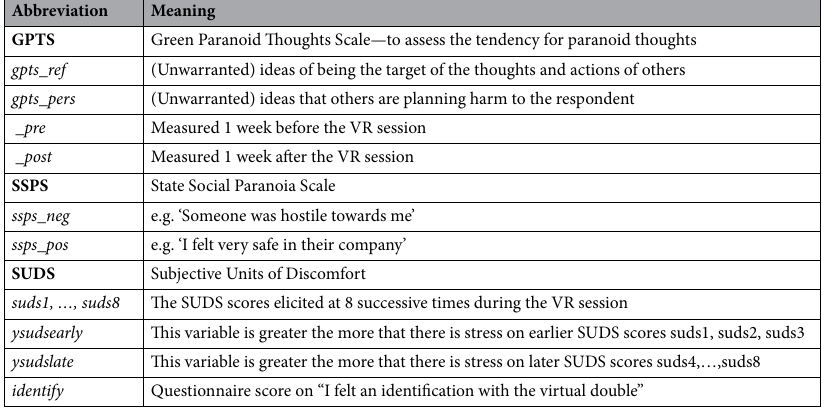
Table 1. Abbreviations of the variable names and their